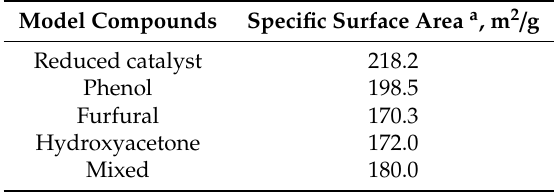
Table 5. BET surface area of the reduced and used